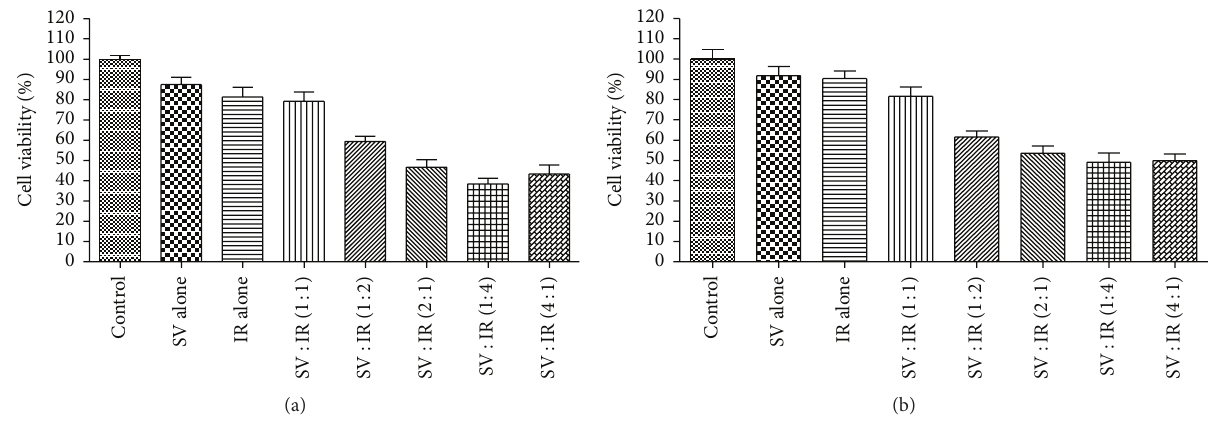
Figure 3: Effect of various fixed ratio combinations of simvastatin and irinotecan on cell viability in HT-29 cells and irinotecan-resistant HT-29 cells. Simvastatin (SV) and irinotecan (IR) were administered at molar ratios of 4 :1, 2: 1, 1: 1, 1: 2, and 1: 4 based on IC 50 values of these two drugs on HT-29 cells and HT-29R cells. Cell proliferation of HT-29 (a) and HT-29R cells (b) at various molar ratios of both drugs was measured by MTT assay. These results showed that combined treatment of irinotecan with simvastatin more potently suppressed cell proliferation of HT-29 cells even with resistance to irinotecan as well as without resistance to irinotecan. The data are expressed as the means ± SD from three independent experiments. Table 1: Drug concentrations of simvastatin and irinotecan at various molar ratio based on IC 50 value of each drug in HT-29 cells and irinotecan-resistant HT-29 cells. HT-29 Molar ratio 28.85 57.7 115.4